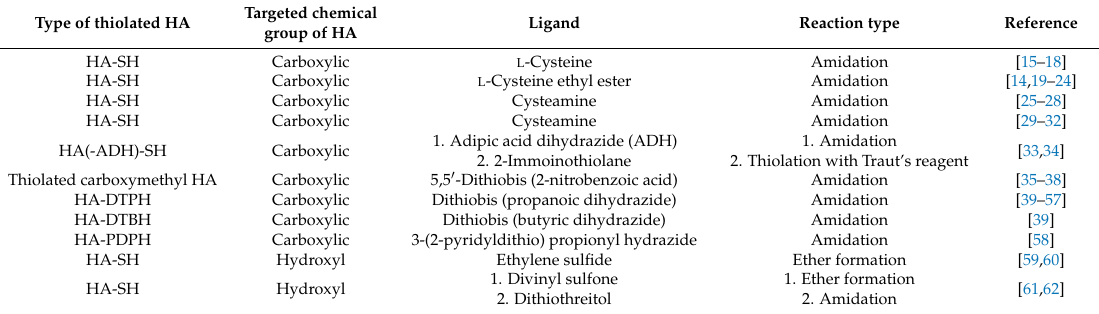
Table 1. Overview various thiolated HAs including type of thiolated HA, targeted chemical group of HA, ligand and reaction type.